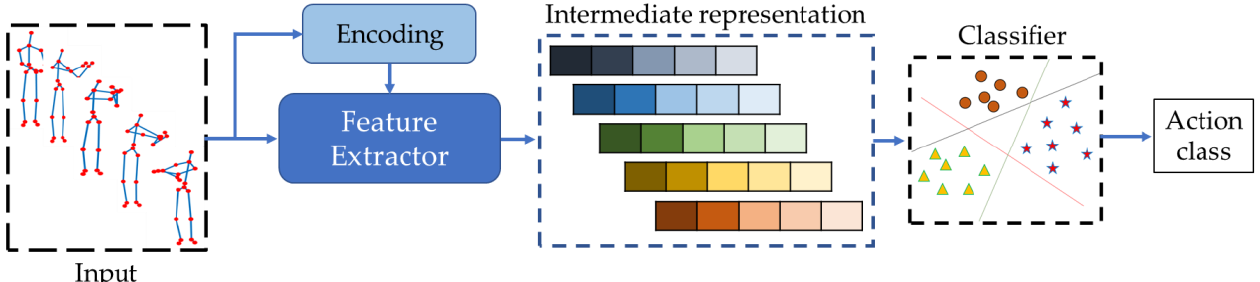
Figure 5. Working scenario of traditional machine learning-based HAR methods.